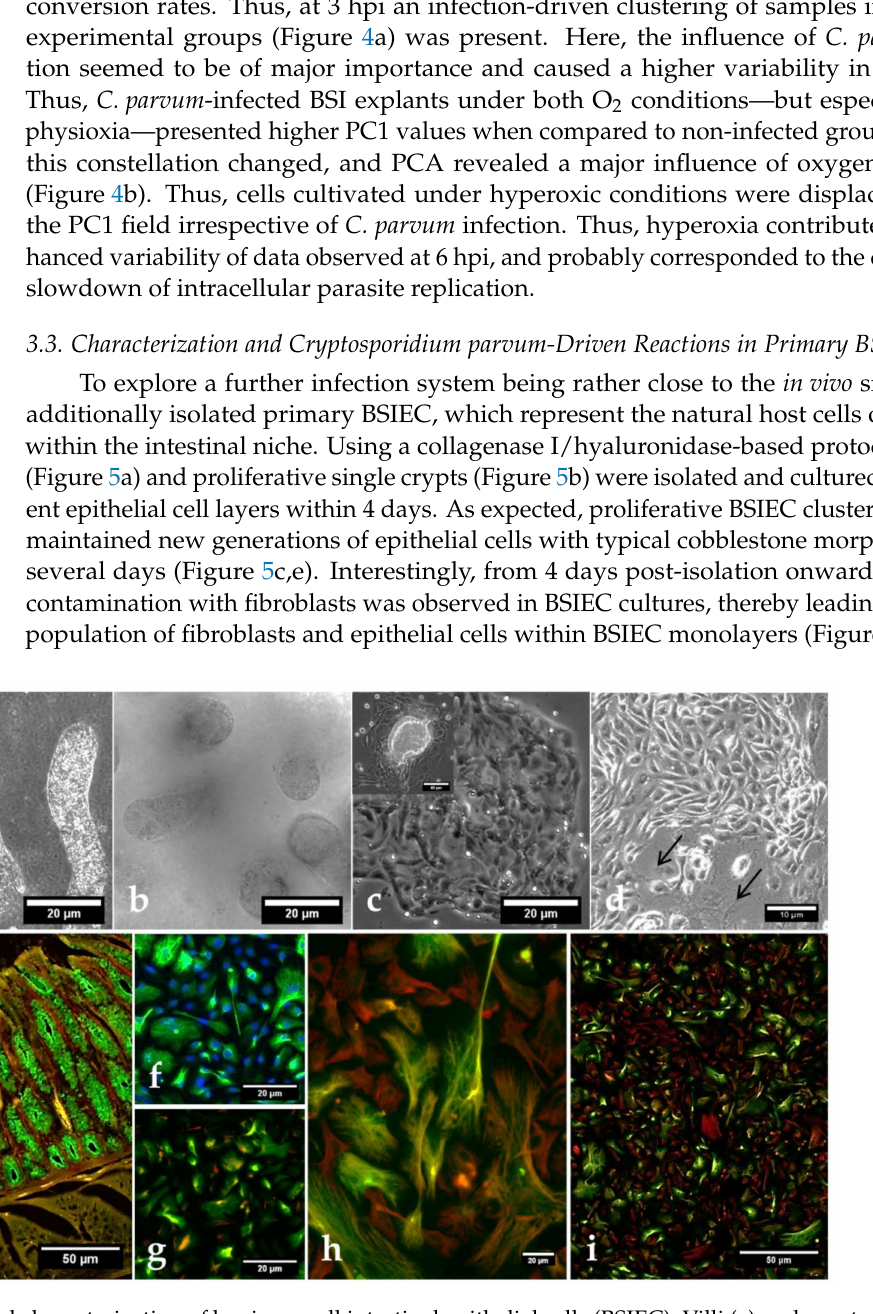
Figure 5. Morphology and characterization of bovine small intestinal epithelial cells (BSIEC). Villi ( a ) and crypts ( b ) after collagenase–hyaluronidase digestion, cell aggregates originating from attached crypts at 24 h post-isolation (c upper left photo), and well-differentiated BSIEC clusters with cobblestone cell morphology at 48 h post-isolation ( c ). Mixture of epithelial cells and fibroblasts (arrows) observed at 4 days post-isolation ( d ). For cell-type characterization, BSIEC were stained with cytokeratin (green, marker of epithelial cells), vimentin (red, marker of mesenchymal cells) and, eventually, with DAPI (blue, DNA). Cryosection of bovine small intestine (positive control) ( e ). ( f – i ): BSIEC after one week ( f ), two weeks ( g ), and three weeks ( h – i ) of in vitro